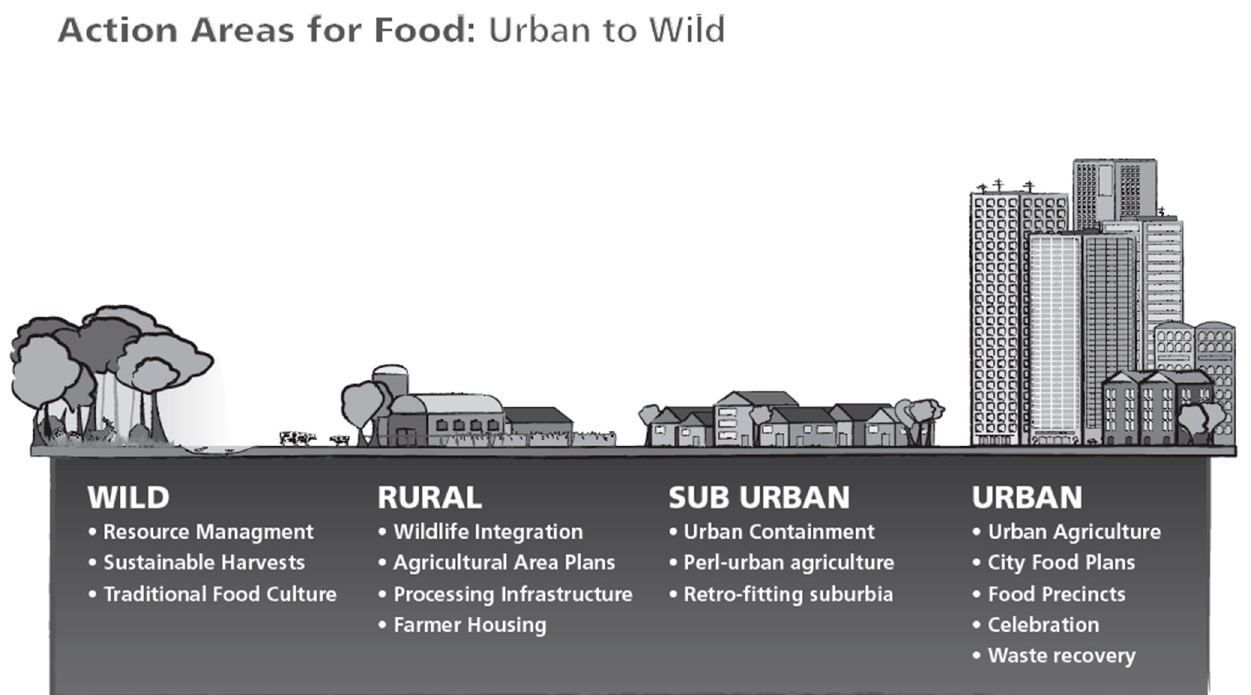
Figure 5. Action areas for food, from ‘wild’ to ‘urban’, as conceived in de la Salle and Holland’s Agricultural Urbanism. Image courtesy of de la Salle and Holland.